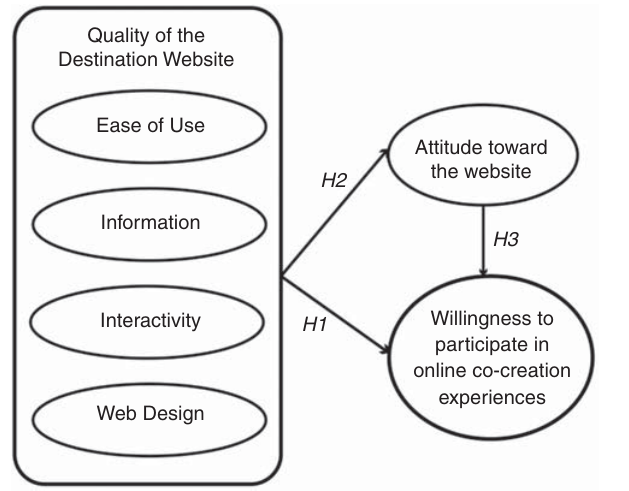
Figure 1. Conceptual